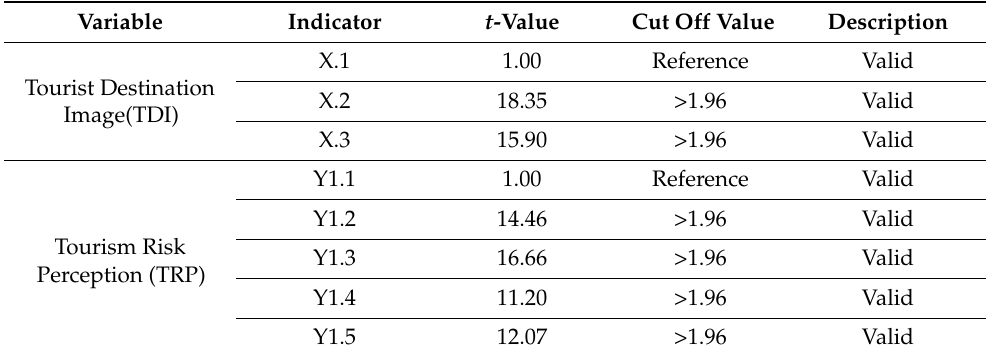
Table 5. Validity Test